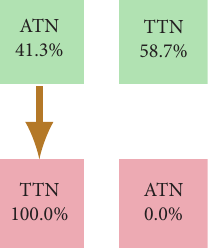
Figure 23: Error analysis regarding the classification of TTNs vs. ATNs by means of cos AV [¬ w, ∞ , ϕ